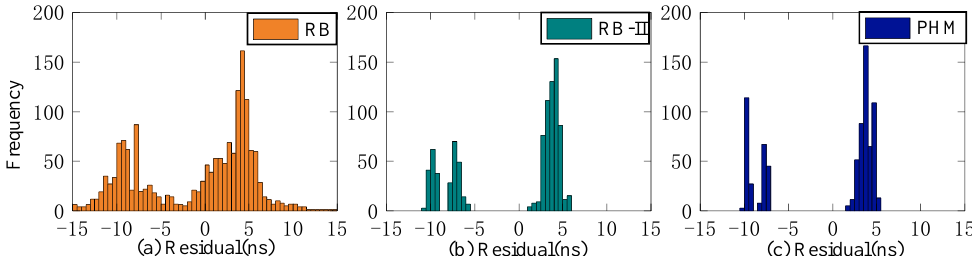
Figure 24. Multiday prediction residual statistics of the QP model. ( a ) The residual distribution of the RB clock. ( b ) The residual distribution of the Rb-II clock. ( c ) The residual distribution of the PHM clock.